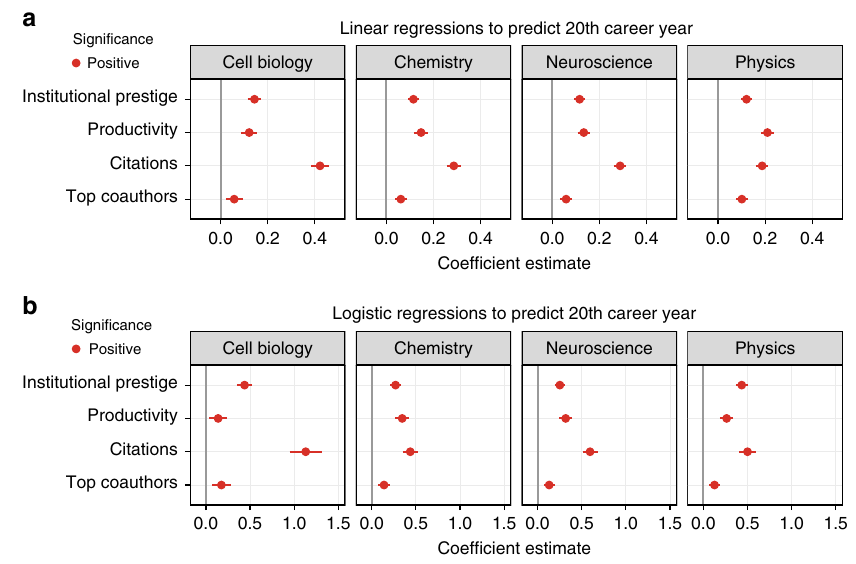
Fig. 3 Regression analysis of long-term career impact. a Results from discipline-speci fi c linear regressions whose dependent variable is the number of citations accrued in the fi rst 20 career years ( R 2 ¼ 0 : 33 ; 0 : 21 ; 0 : 18 ; and 0 : 19 for Cell Biology, Chemistry, Neuroscience, and Physics, respectively). b Results from discipline-speci fi c logistic regressions whose dependent variable is a binary indicator denoting whether a junior researcher is a top scientist in her 20th career year ( AUC ¼ 0 : 785 ; 0 : 711 ; 0 : 726 ; and 0 : 749 for Cell Biology, Chemistry, Neuroscience, and Physics, respectively). In all cases there is a statistically signi fi cant positive relationship between coauthorship with a top scientist in the fi rst 3 career years and long-term impact. Bars refer to to 95% con fi dence